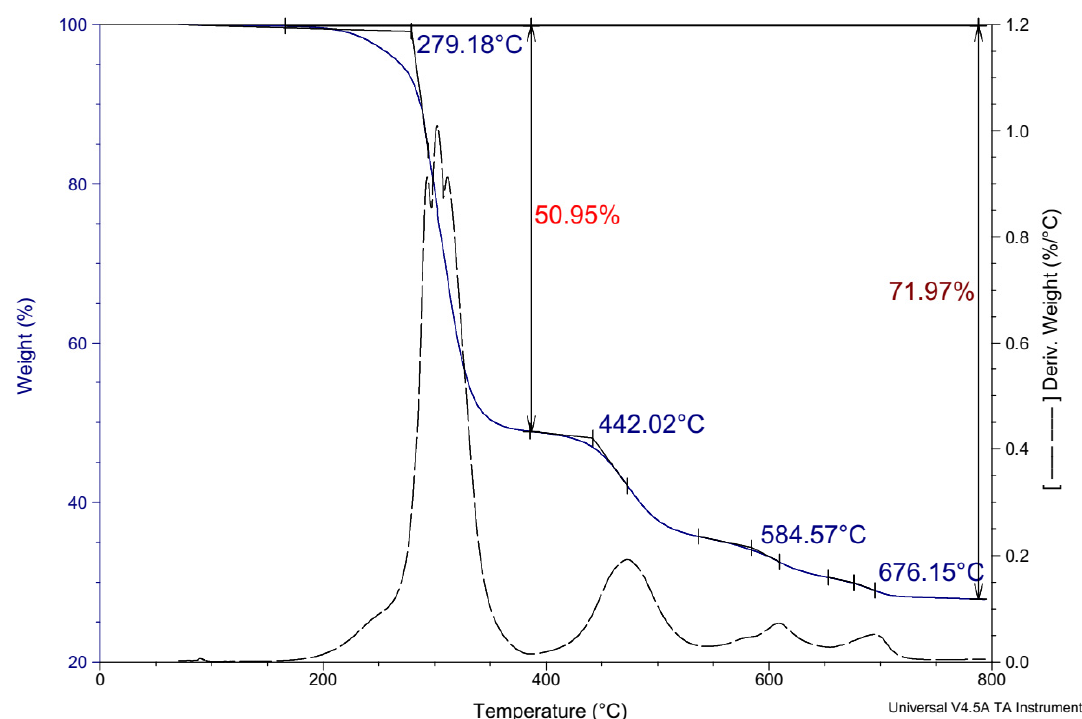
Figure 19. TGA decomposition curve for insulations of a PVC coaxial power cable.